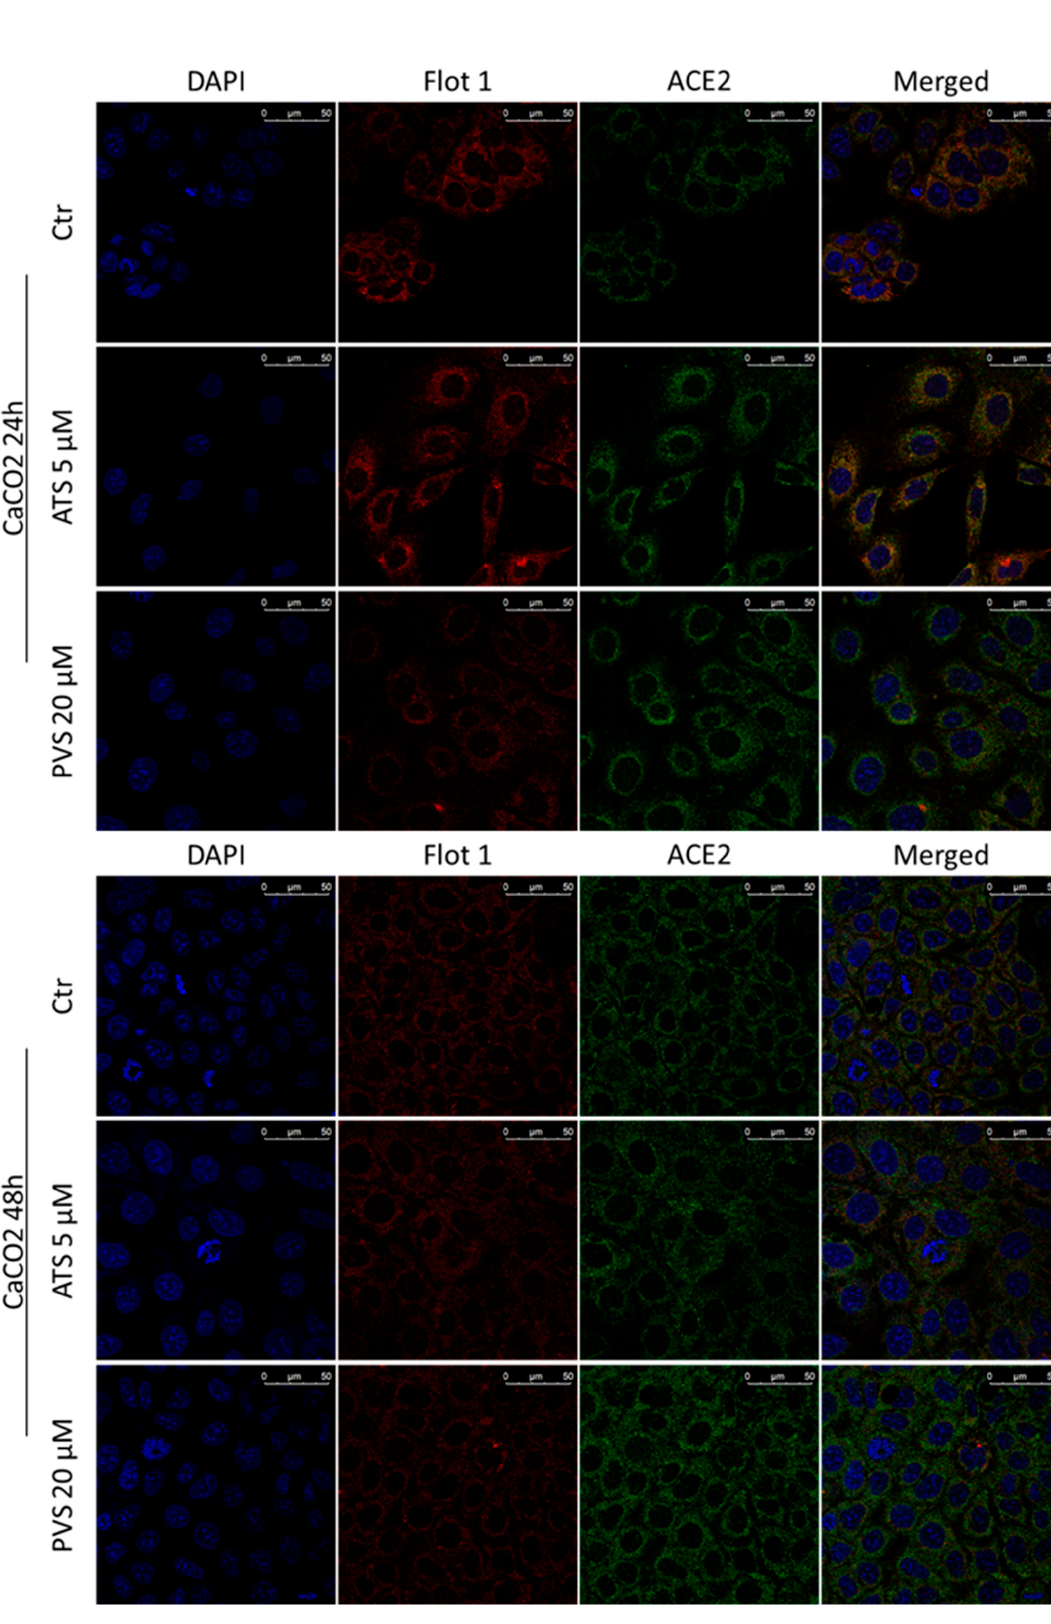
Figure 7. Representative confocal microscopy images of Flotillin-1 (red) and ACE2 receptor (green) in CaCO2 cells treated with ATS or PVS at indicated doses and time points. Nuclei were stained with DAPI (blue fluorescence). Scale bar 50 µm.